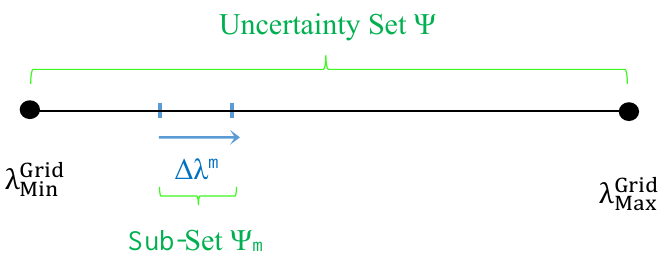
Figure 5. Robustness region for the electricity price uncertainty.